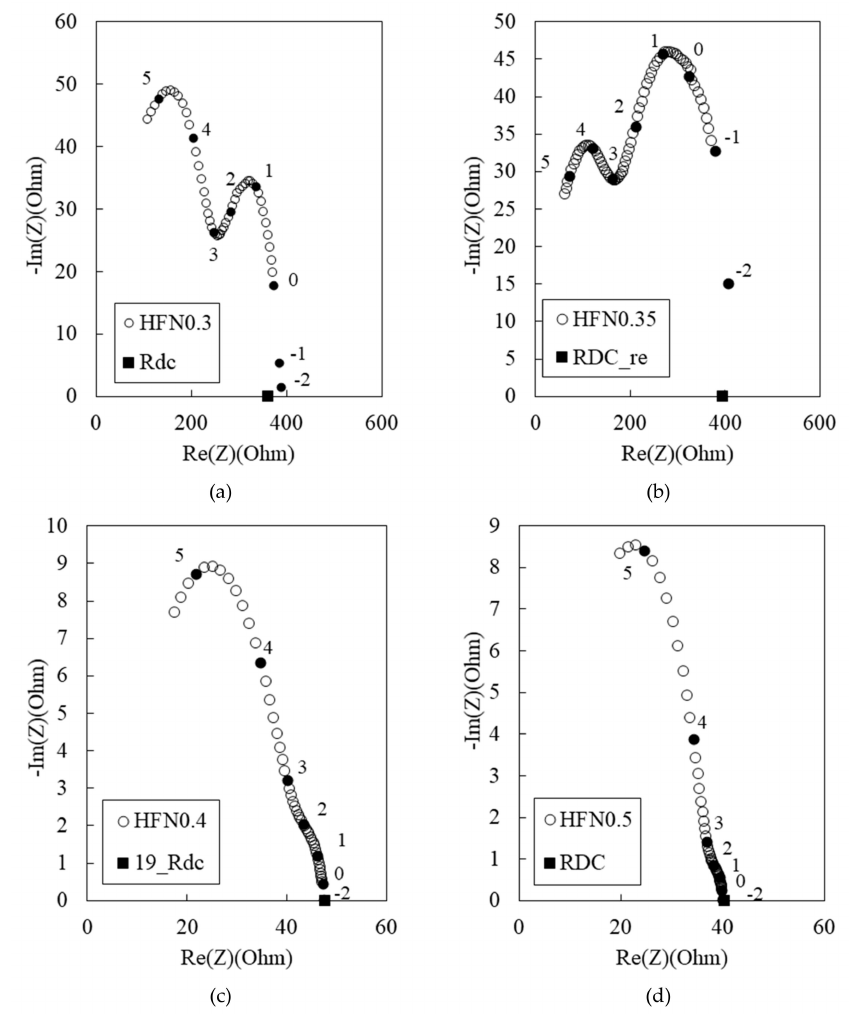
Figure 8. Experimental Nyquist plots for 180 MPa-HPFRCC (w / c ratio of 0.3) with ( a ) 0.3%, ( b ) 0.35%, ( c ) 0.4%, and ( d ) 0.5%